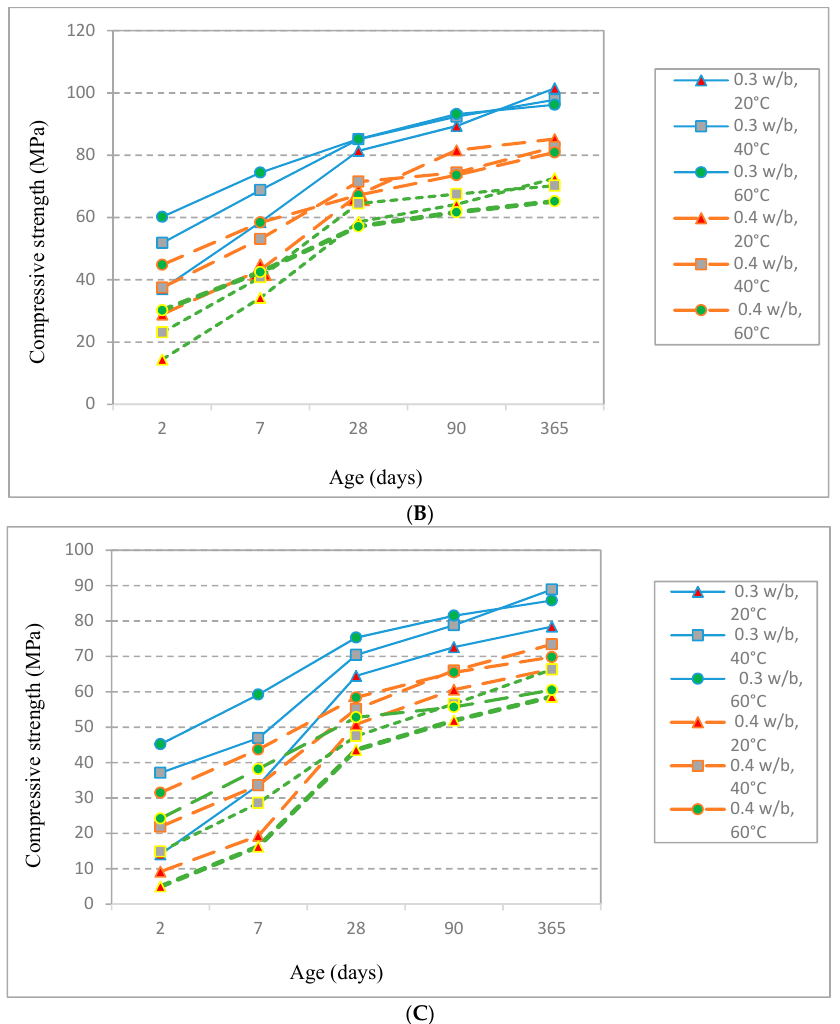
Figure 5. Compressive strength (MPa) at various water curing temperatures and ages for ( A ) OPC; ( B ) BFS40; ( C ) BFS80 pastes The losses in compressive strengths (COE %) and age of COE for OPC and BFS40 pastes were calculated from the original results provided by the researchers (Table 2). However, no COE was observed for BFS80 at all w/b ratios with 20–60 °C increase in water curing temperature up to 365 days. Table 2. COE records with 20–60 °C increase in water curing temperature at ages up to 365 days for ordinary Portland cement (OPC), BFS40 and BFS80 pastes Paste Name w/b Ratio Age at Which COE Occurred COE (%) 28 7.2 0.3 OPC paste